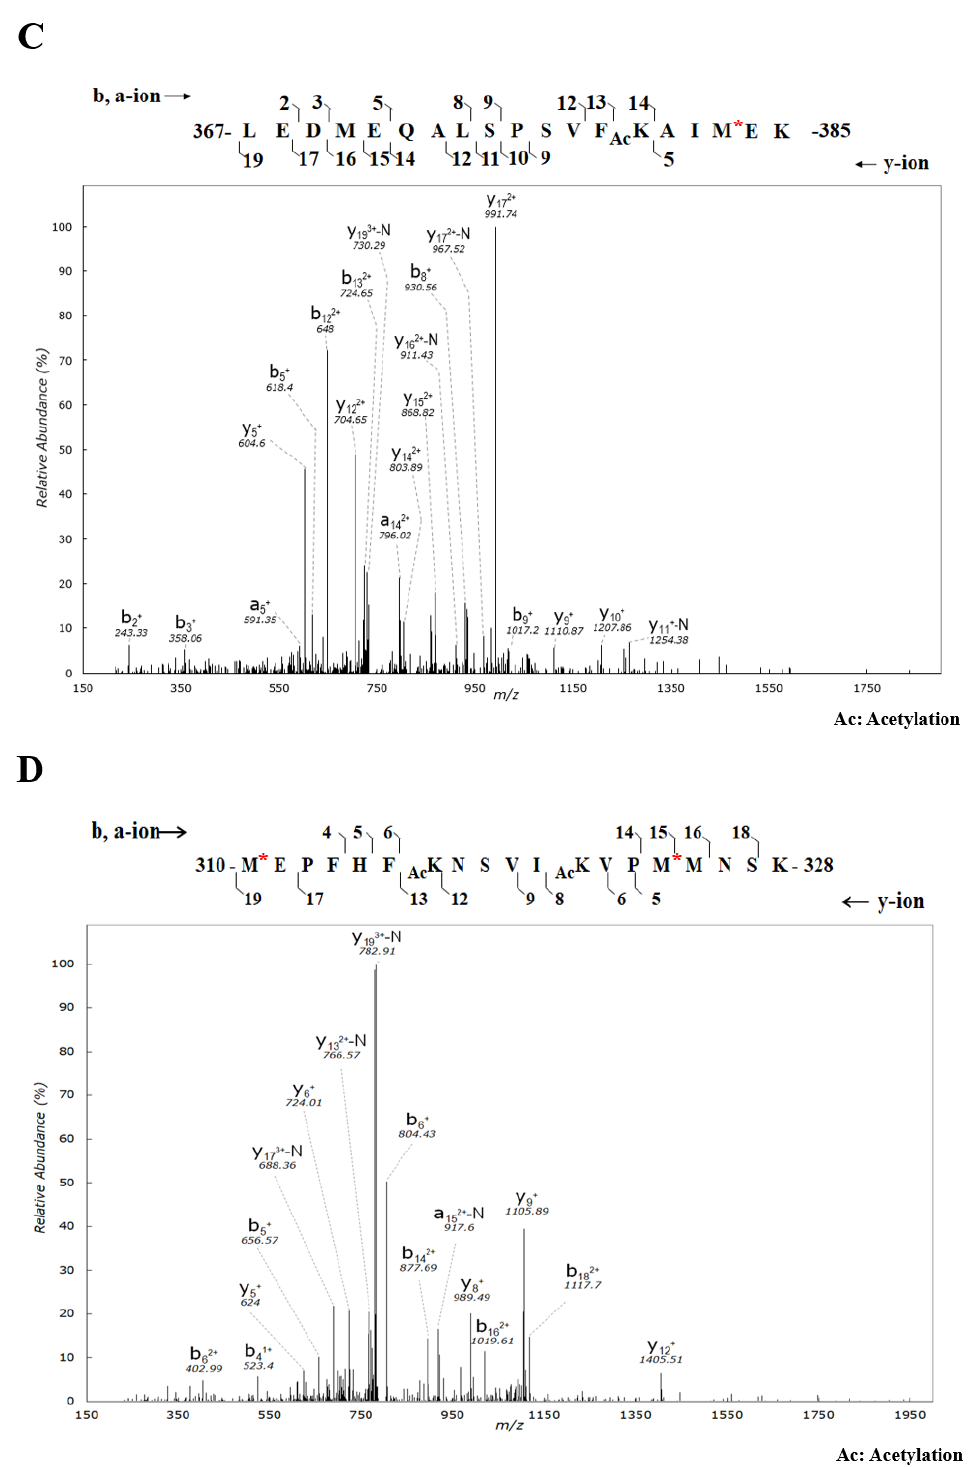
Figure 1. Gel stained with Coomassie Brilliant Blue (CBB) and cut according to molecular weights of 96–105 kDa ( A ). Identification of novel types of acetylation (Ac) modifications of the C1-inhibitor (INH) ( B ). Representative tandem mass spectrometry (MS / MS) spectra of the 367 -LEDMEQALSPSVFKAIMEK- 385 peptide sequence and the modified peptide bearing the acetylated K380 residue ( C ). MS / MS spectrum of 310 -MEPFHFKNSVIKVPMMNSK- 328 and the modified peptide bearing the Ac-modified sites of K316 and K321 residues ( D ).